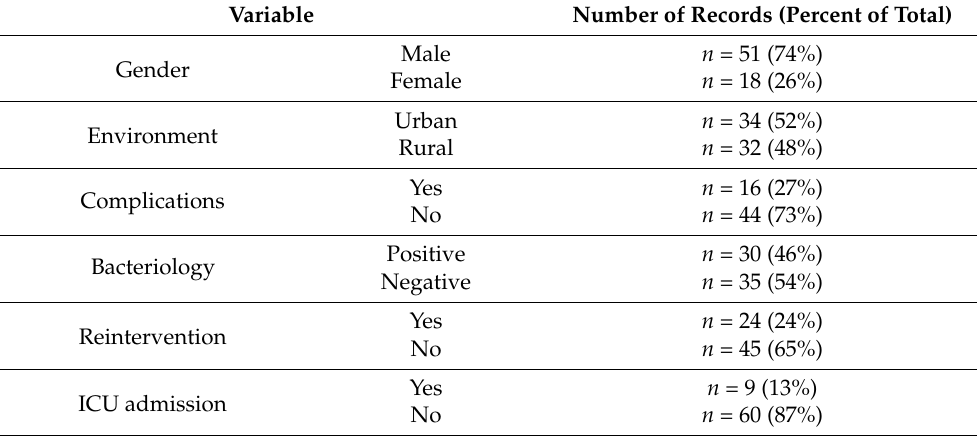
Table 2. Qualitative variables from patient records regarding gender, home environment, lesion bacteriological assay results, official diagnosis category, complications, reintervention, and ICU admission.